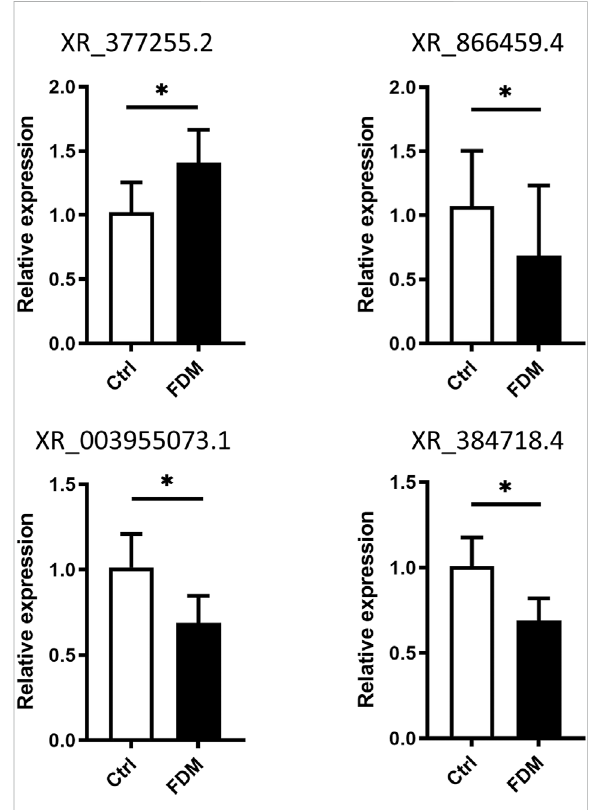
FIGURE 7 ValidationofdifferentiallncRNAexpressionbyqRT – PCR.The relative expression of the lncRNAs XR_377255.2, XR_866459.4, XR_003955073.1, and XR_384718.4 in the retinas from FDM eyes andfellow control eyesisshown. Foreach group, n =6. *, p < 0.05, Student t